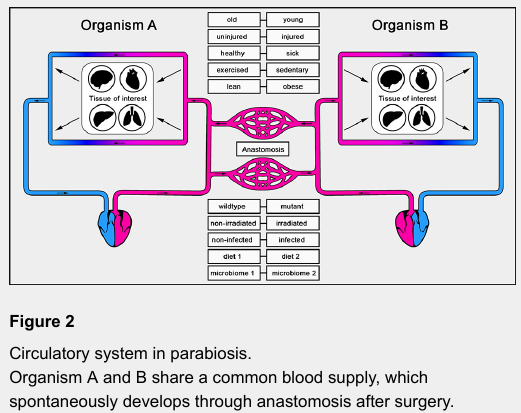
Circulatory system in parabiosis. Organism A and B share a common blood supply, which spontaneously develops through anastomosis after surgery. Organisms with different physiological conditions may be used for parabiosis in order to assess the systemic effect of one organism on a particular tissue of interest in its attached